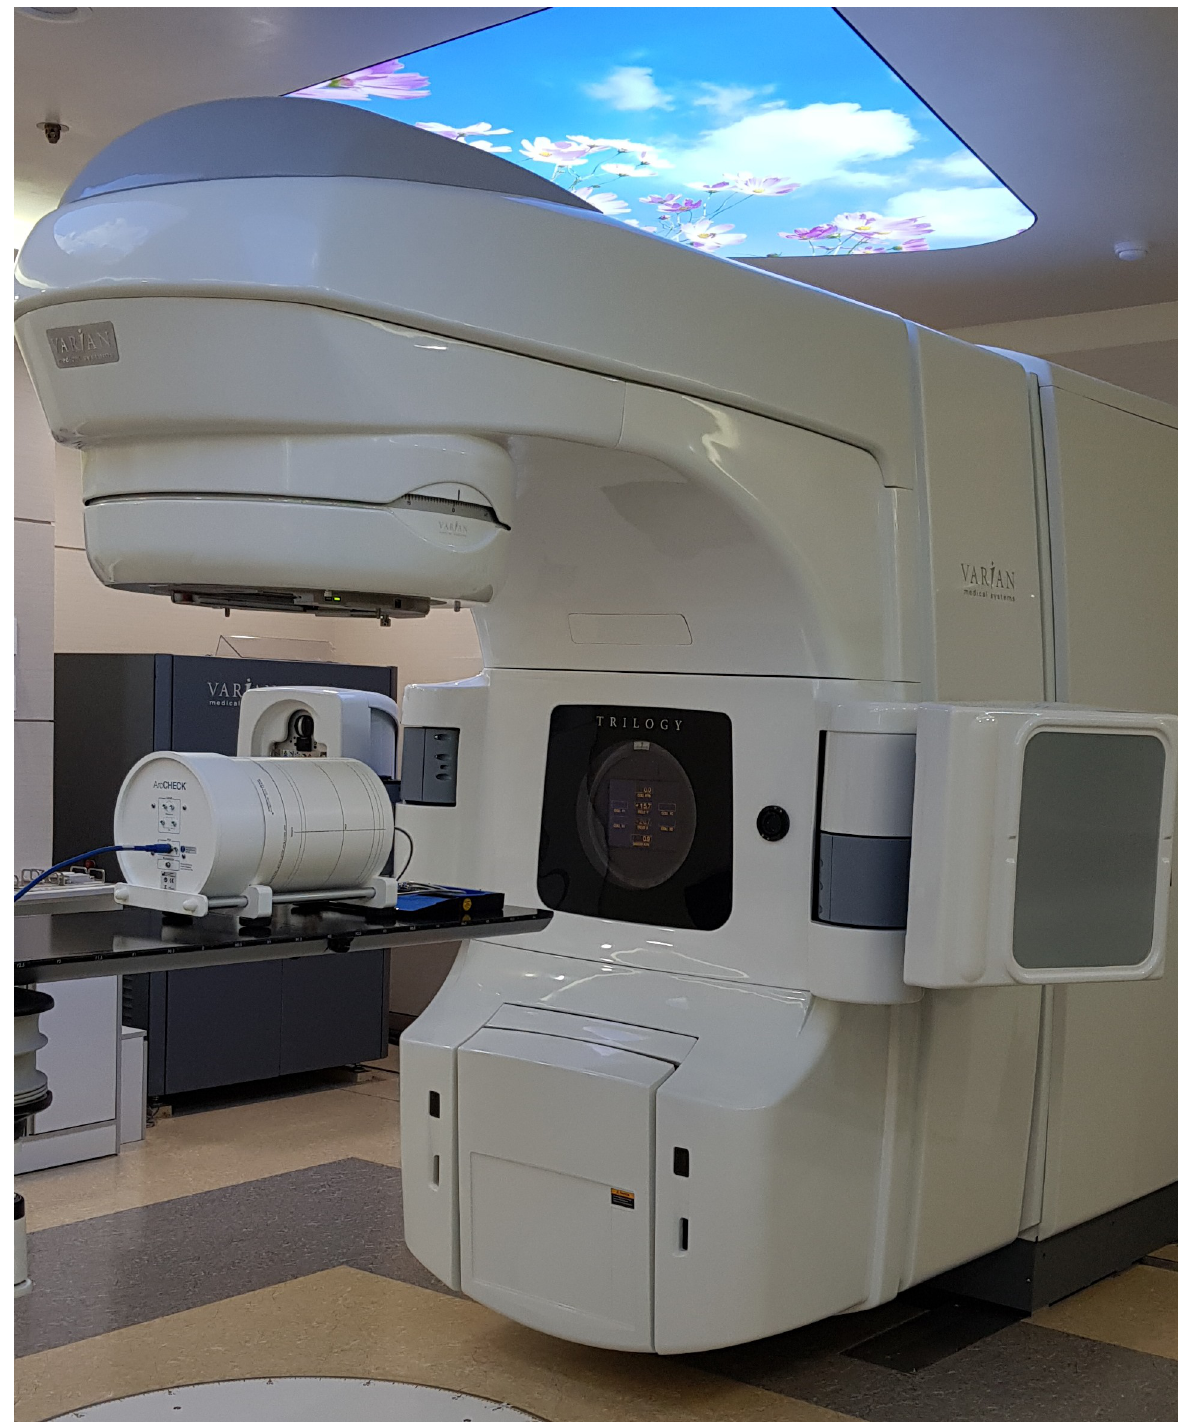
Fig 5. Dose measurement with ArcCHECK for the dose reconstruction with the 3DVH